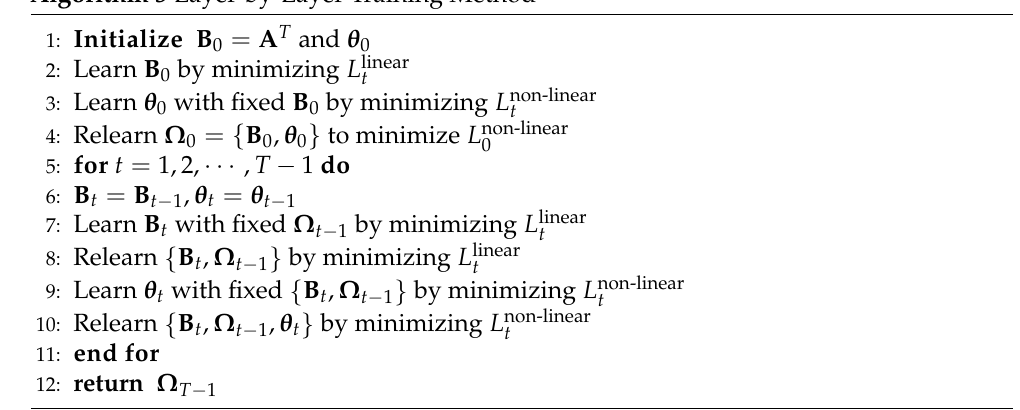
Algorithm 3 Layer-by-Layer Training